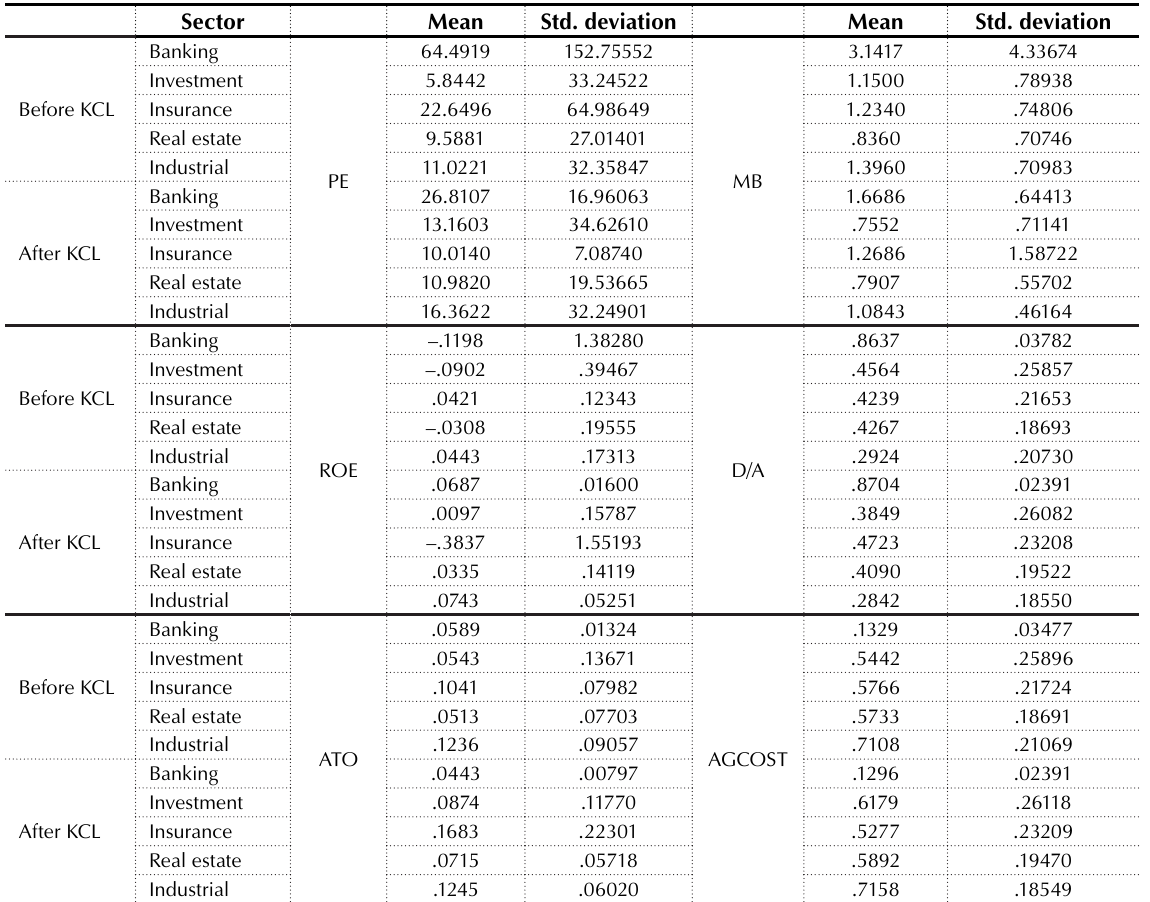
Table 2. Summary results of the mean and standard deviation before and after KCL